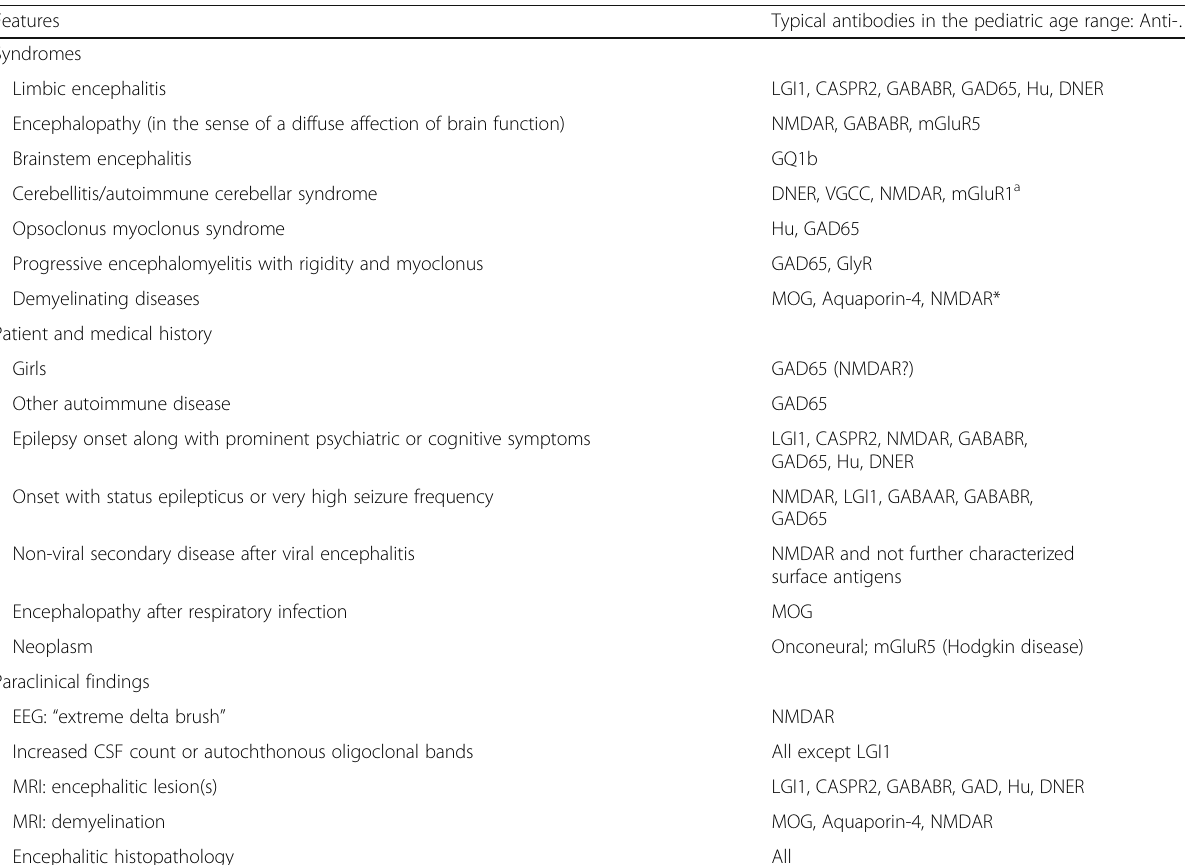
Table 1 Features and antibodies characteristic of autoimmune encephalitis in children and adolescents. The list of antibodies may not be exhaustive, as the field is still young and there are still reports of new associations from the pediatric age range. Abbreviations are spelled out in the list at the beginning of the article